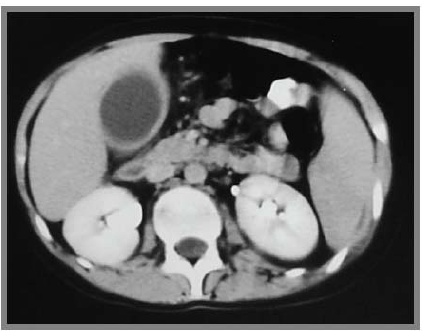
Fig. 1 Computed tomography revealed isodense structure measuring 25 mm inside the gallbladder lumen, consistent with a hematoma. Also, increased wall thickness and hy- drops was noted accompanied by an increase in intraluminal